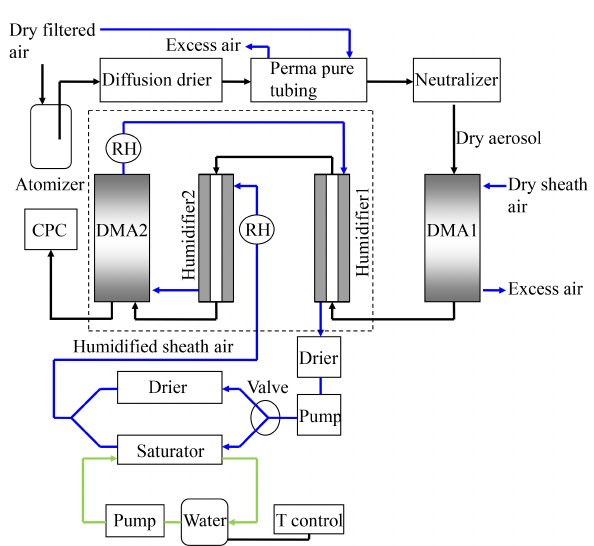
Figure 1. Schematic setup of the hygroscopicity tandem differential mobility analyzer (HTDMA)